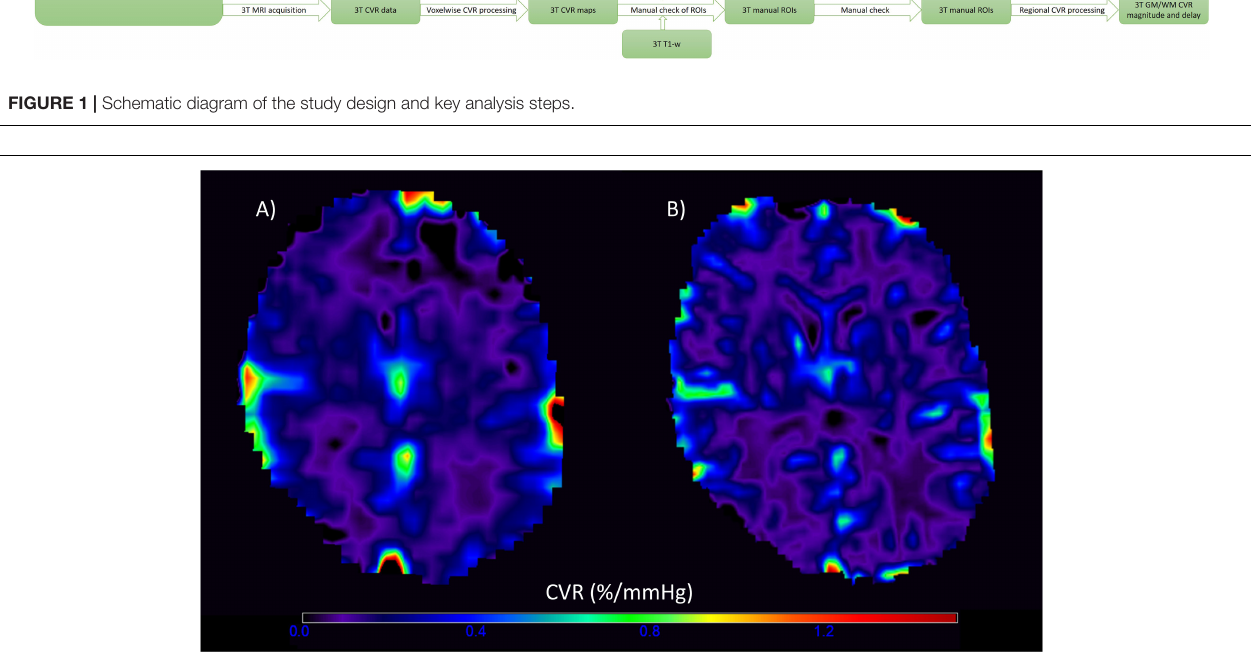
FIGURE 2 | Representative voxelwise cerebrovascular reactivity (CVR) magnitude maps at 1.5T (A) and 3T (B) in the visit-specific T2-w space. The higher spatial resolution and CVR magnitude values are evident in the 3T